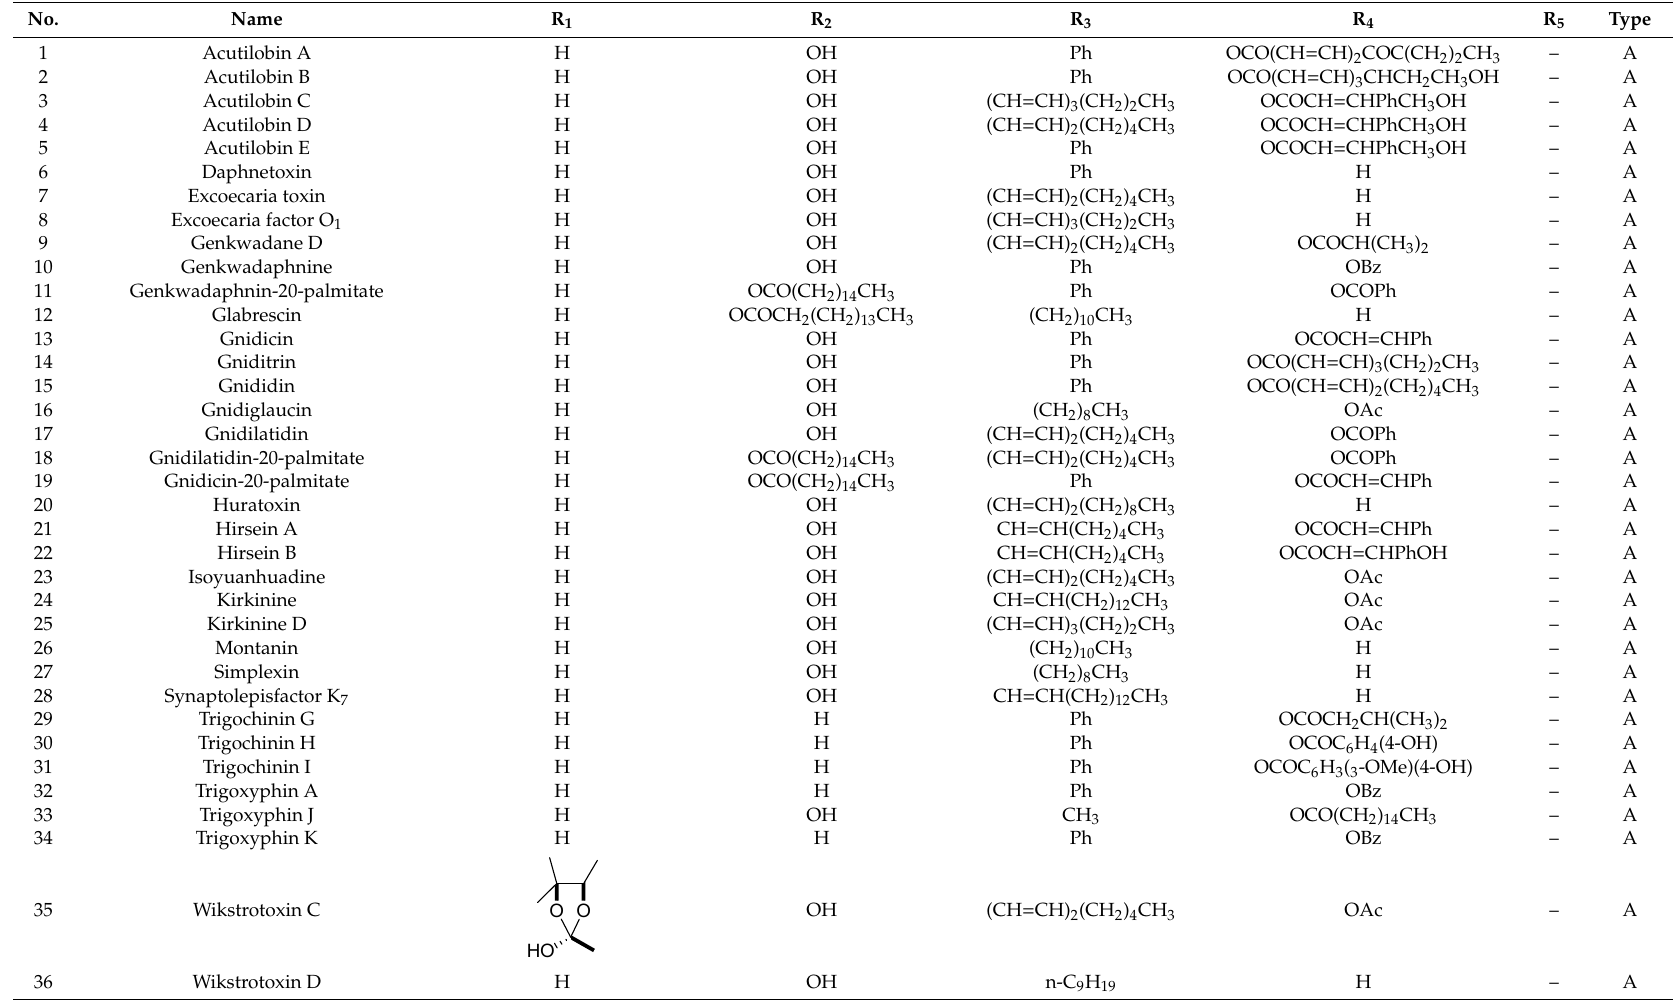
Table 2. Reported structures of 6-epoxy daphnane